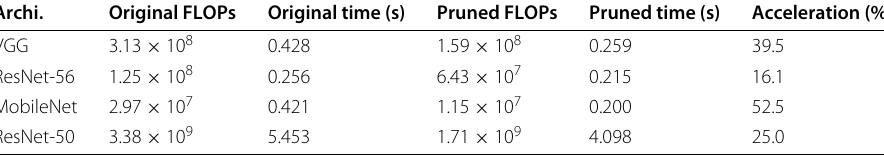
Table 6 Theoretical amount of computation in FLOPs and the corresponding acceleration in practice Archi.